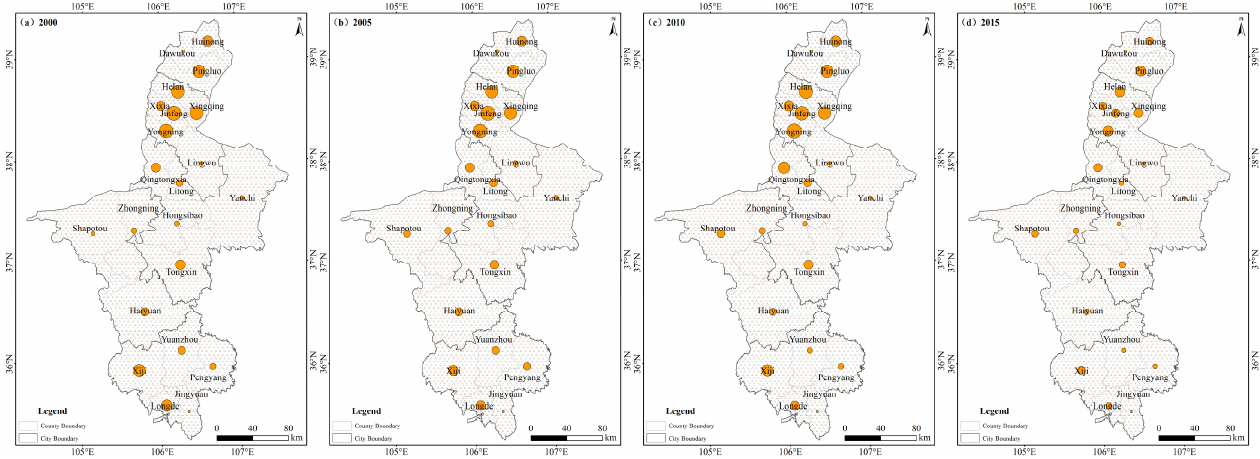
Figure 9. LERI on the county scale in Ningxia from 2000 to 2015.